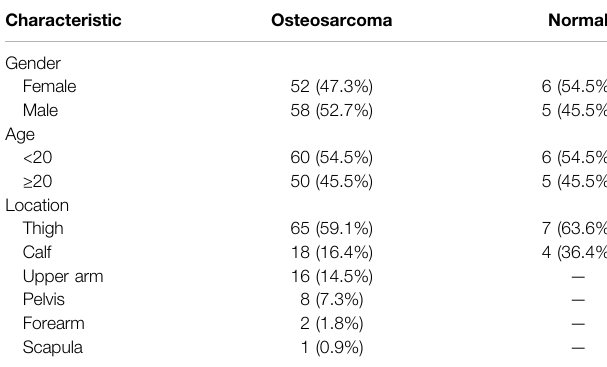
TABLE 1 | Clinical information for patients with